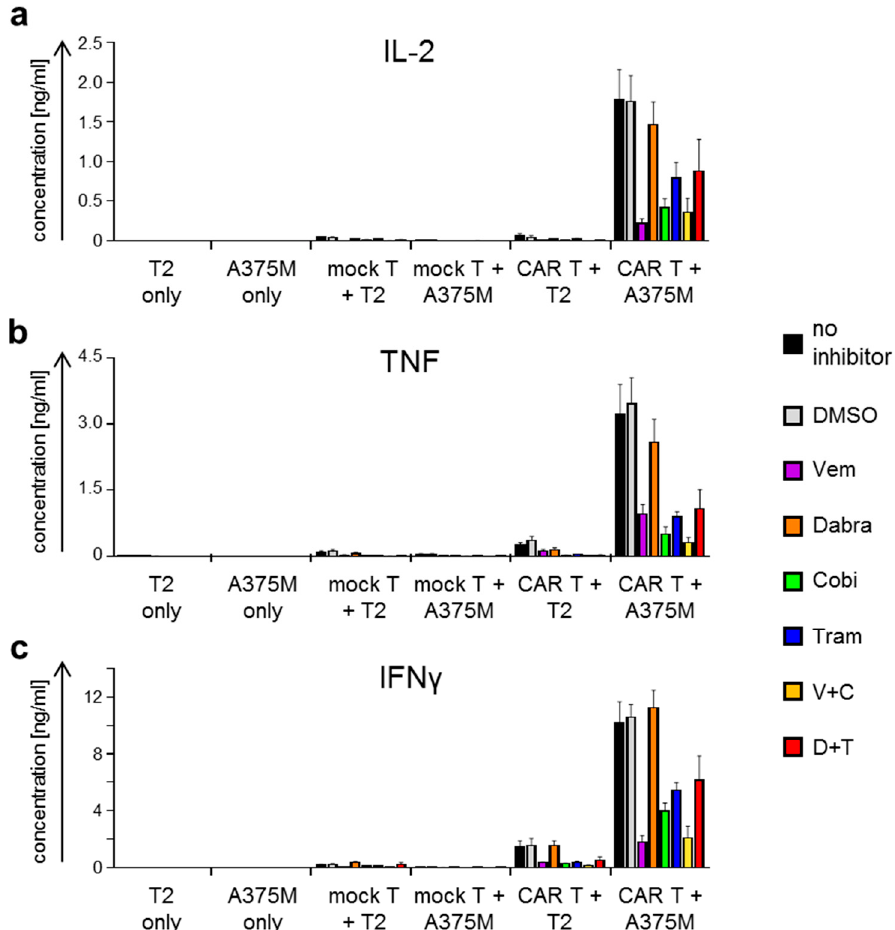
Figure 3. BRAF and MEK inhibitor treatment affects CAR-T-cell cytokine secretion after antigen-specific stimulation. CAR-T cells were generated as described in Figure 1. Four hours after electroporation, these cells were co-incubated overnight with CSPG4-negative T2 cells and the CSPG4 + melanoma cell line A375M at a 1:1 ratio. Mock-transfected T cells (mock T) were used as control. Co-incubations were performed in the absence of inhibitors (no inhibitor), in the presence of DMSO only (solvent control), or in the presence of the different kinase inhibitors, either alone or in combination. The used kinase inhibitors vemurafenib (Vem, V), dabrafenib (Dabra, D), cobimetinib (Cobi, C), and trametinib (Tram, T) were added in final concentrations listed in Table 1. T2 and A375M cells without T cells and mock-transfected T cells stimulated with T2 or A375M served as negative controls. Concentrations of interleukin (IL)-2 ( a ), tumor necrosis factor (TNF) ( b ), and interferon gamma (IFN γ ) ( c ) were determined after overnight co-incubation with a Cytometric Bead Array (CBA), and are depicted in [ng/mL]. Data are presented as mean + SEM of four independent experiments (original data, see Table S5; for statistical analyses see Tables S6–S8).